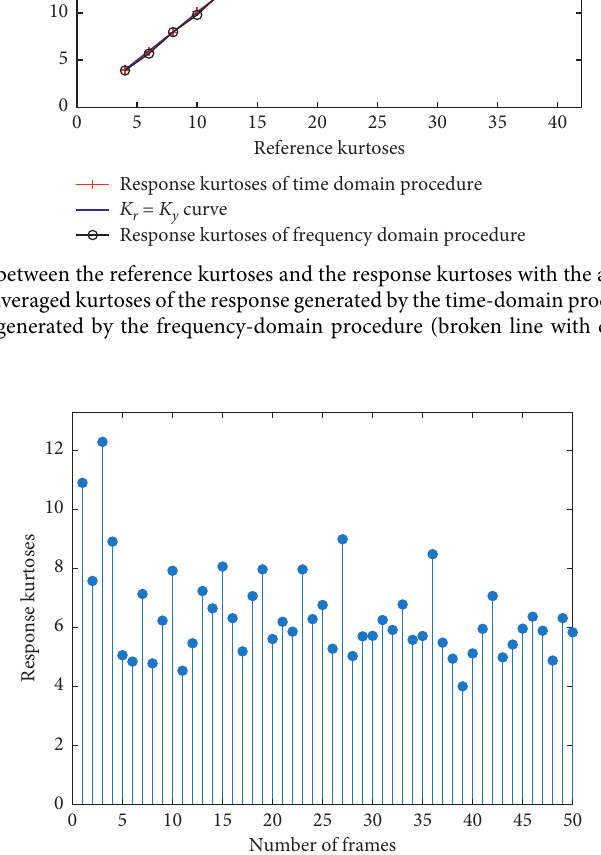
Figure 20: Response kurtoses when the WOA method is applied to the input